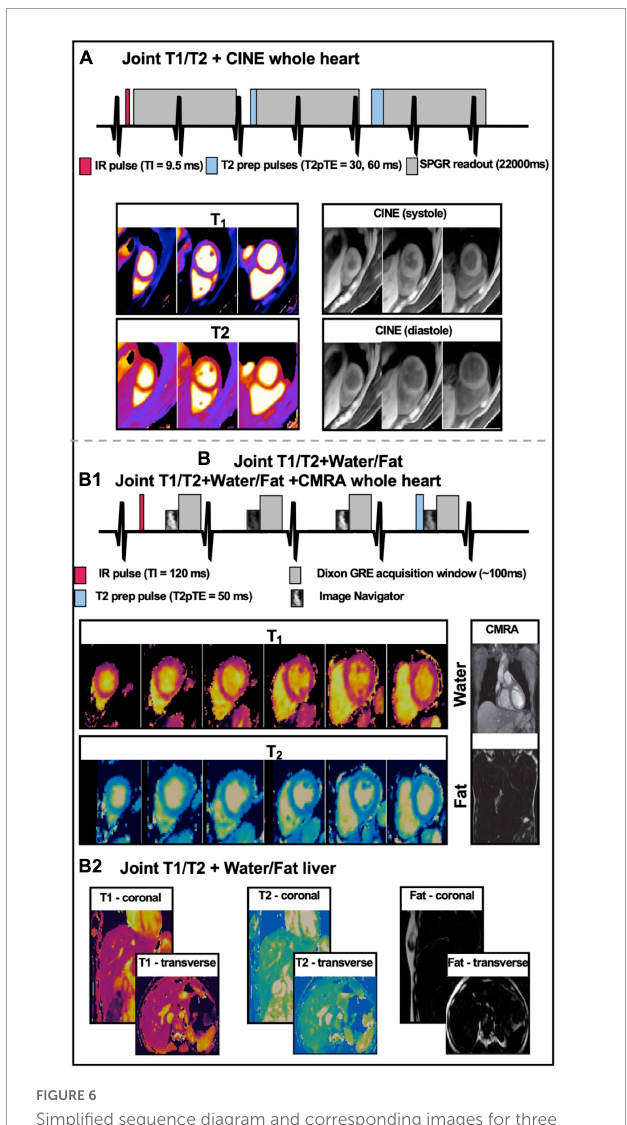
FIGURE6 Simplified sequence diagram and corresponding images for three multi-parametric acquisition frameworks. (A) Short-axis T 1 and T 2 maps, and CINE images at apical, mid-ventricular, and basal levels obtained from a single joint T 1 /T 2 + CINE free-running whole-heart scan. Figure adapted with permission from Qi et al. (128). (B1) Short-axis T 1 and T 2 map slices and a representative slice of water and fat CMRA images, obtained from a single joint whole-heart T 1 /T 2 mapping + Water/FAT CMRA whole heart free-breathing isotropic scan. (B2) Representative coronal and transverse slices of joint T 1 , T 2 maps and Fat images from a 3D isotropic free-breathing liver